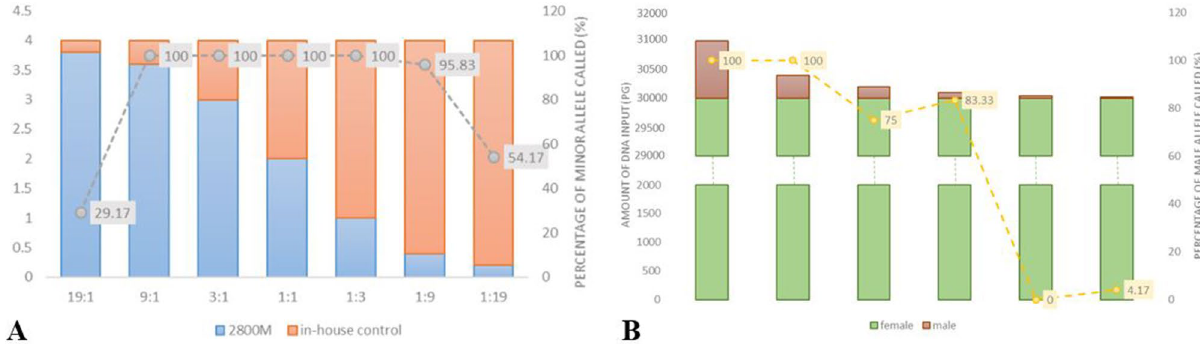
Figure 2. Percentages of allele recovery for the minor contributor with ratios varying from 19:1 to 1:19 in male:male mixture study ( A ). Percentages of allele recovery in male:female mixtures decreasing the male DNA from 1 ng to 25 pg and keeping constant the female DNA to 30 ng ( B